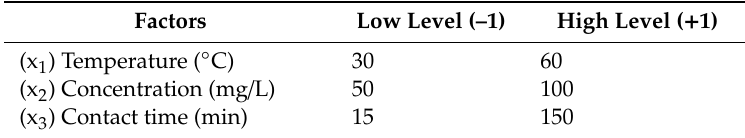
Table 1. Range and levels used for the batch desorption